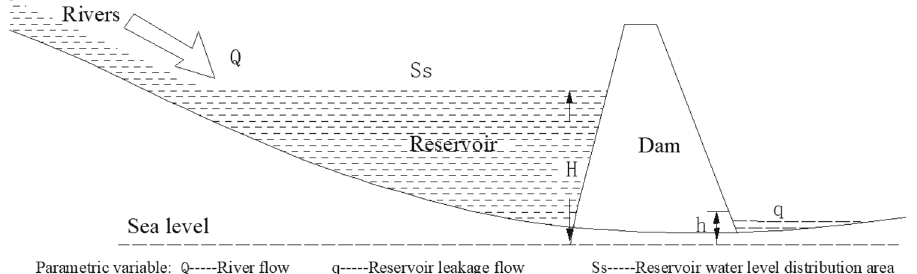
Figure 5. Schematic diagram of unified experiment of flow and